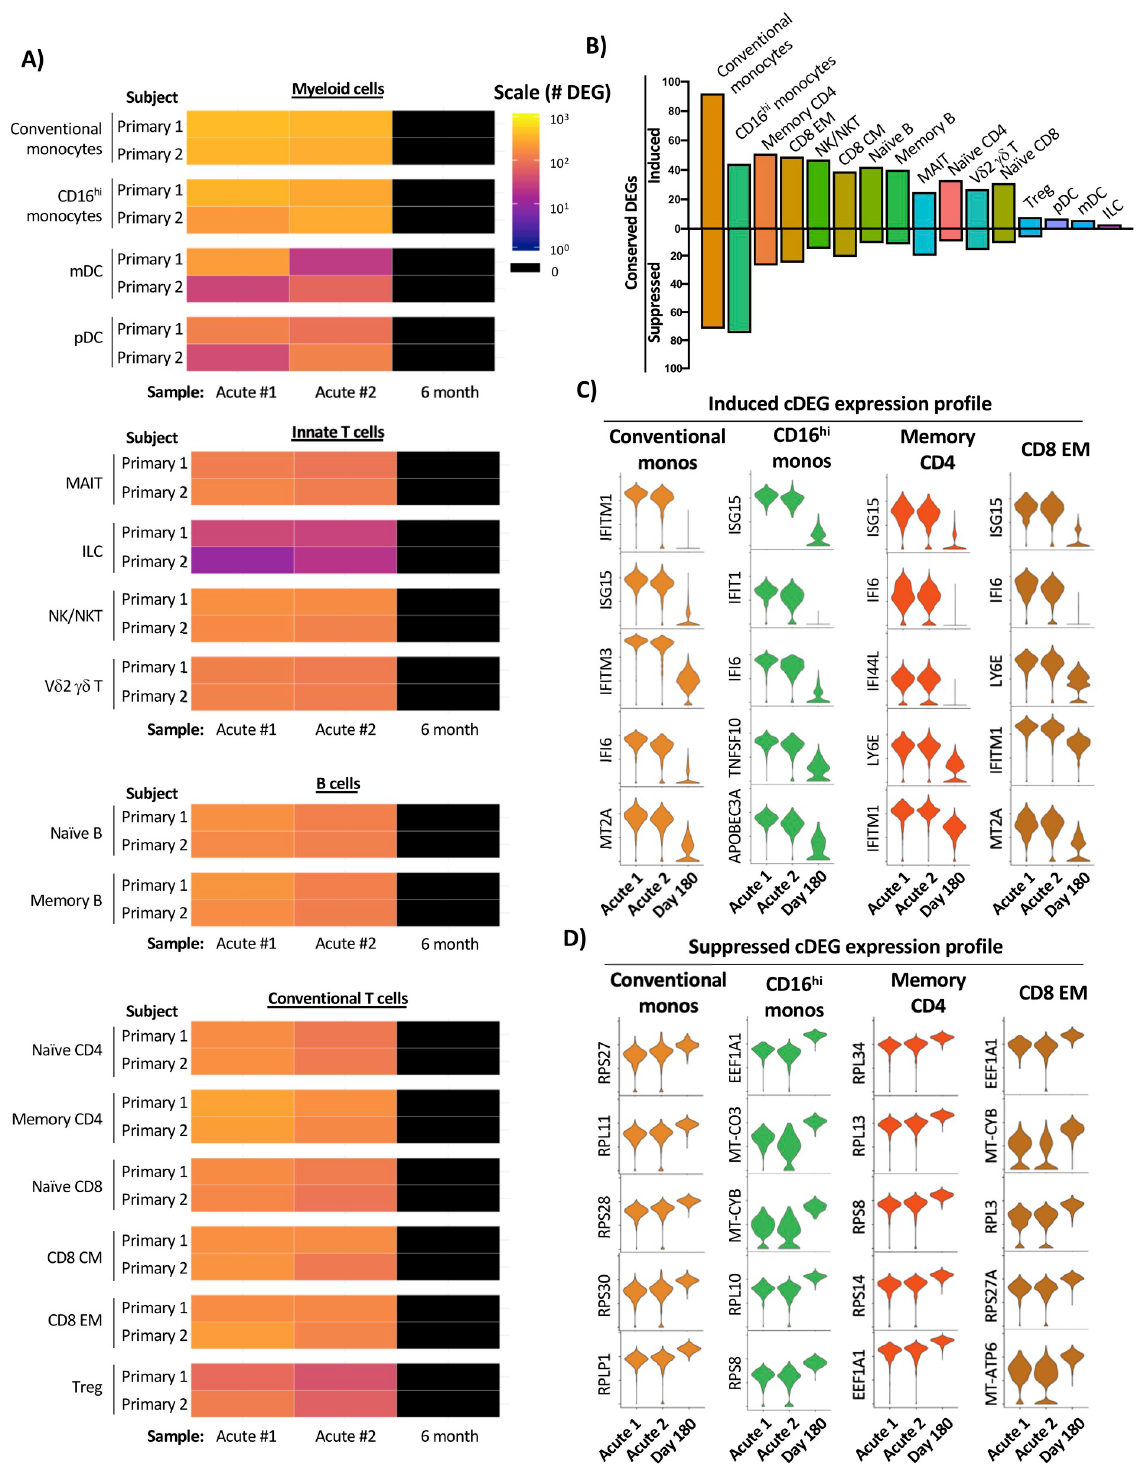
Fig 4. Temporal and transcriptional characterization of natural primary DENV-1 infection and identification of conserved gene signatures. A) Quantification of differential gene expression across all major leukocyte populations following natural primary DENV-1 infection. Subject- and population-specific differentially expressed genes (DEGs) were defined by a Wilcoxon rank-sum test with a Bonferroni correction relative to the 6-month control sample for each subject. B) Population-restricted frequency of cDEGs from both natural primary DENV-1 infection subjects. C) Expression of select induced cDEGs within the indicated cell populations across all study time points. D) Expression of select induced cDEGs within the indicated cell populations across all study time points. https://doi.org/10.1371/journal.ppat.1009240.g004 PLOS Pathogens| https://doi.org/10.1371/journal.ppat.1009240 January29,